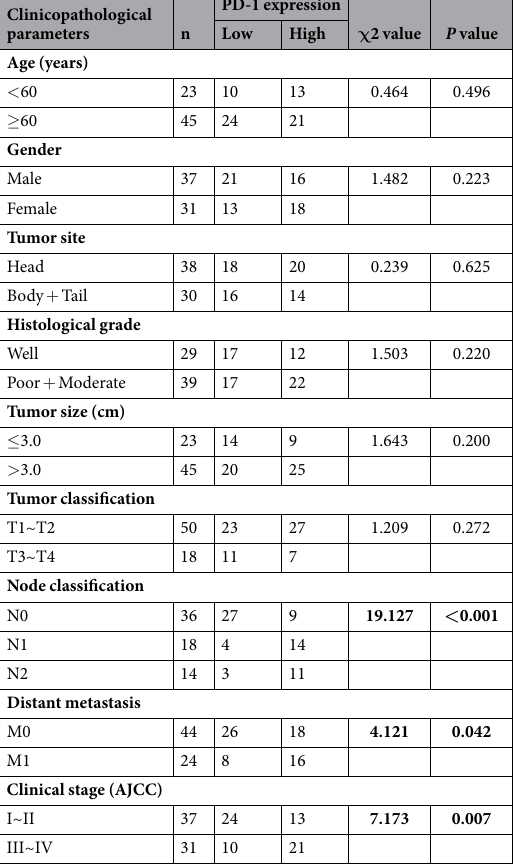
surgical resection at the Department of General Surgery, Sir Run Run Shaw Hospital of Zhejiang University School of Medicine between September 2012 and March 2014. All cases were confirmed by pathological diag- nosis. Pathologic classification was performed according to 8th edition of AJCC. Among the 94 PDAC patients, 5 patients presented with stage IA disease, 21 patients presented with stage IB disease, 7 patients presented with stage IIA disease, 22 patients presented with stage IIB disease, 8 patients presented with stage III disease and 31 patients presented with stage IV disease. The cases of PDAC were selected in this study only if clinical data were available. For the analysis of disease-free survival or overall survival, the follow-up time was calculated from the date of surgery to the date of recurrence or death, or the last known follow-up, respectively. Recurrence included locoregional, local, and distant metastasis. None of them had received radiotherapy, chemotherapy, hormone therapy or other related anti-tumor therapies before or after surgery. For each case, tissue block containing tumor or adjacent normal pancreatic tissue was selected and 2–3 μ m sections were cut.